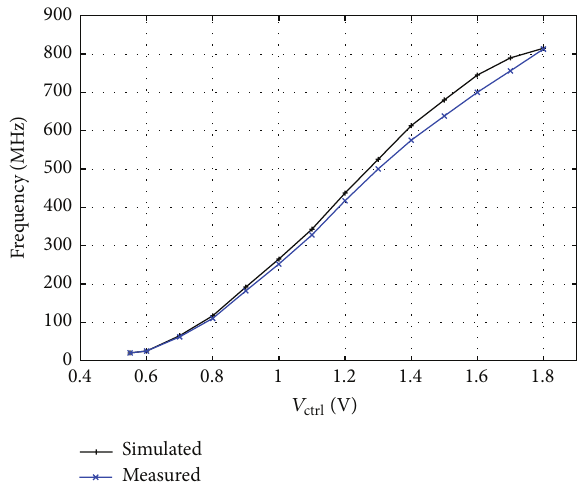
Figure 10: Frequency-voltage control characteristics